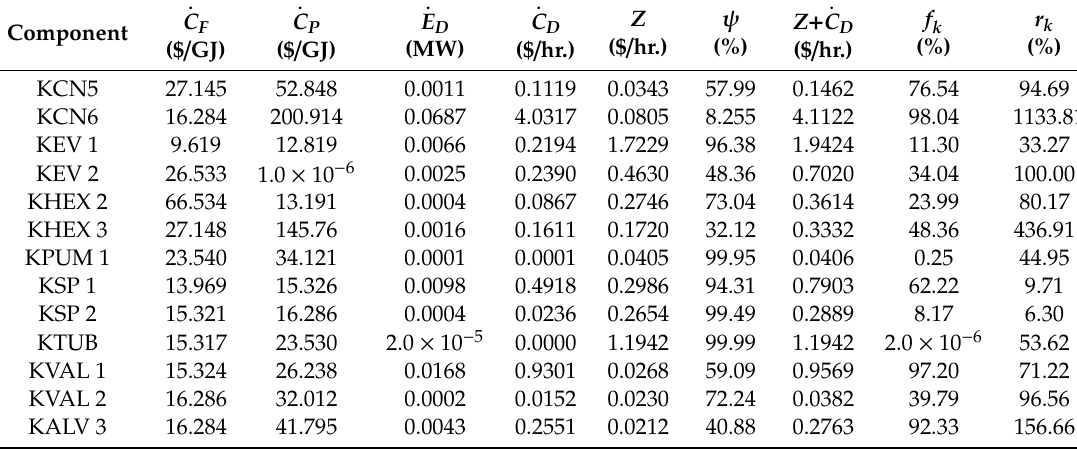
Table 8. Exergoeconomic parameters for the Kalina power cooling